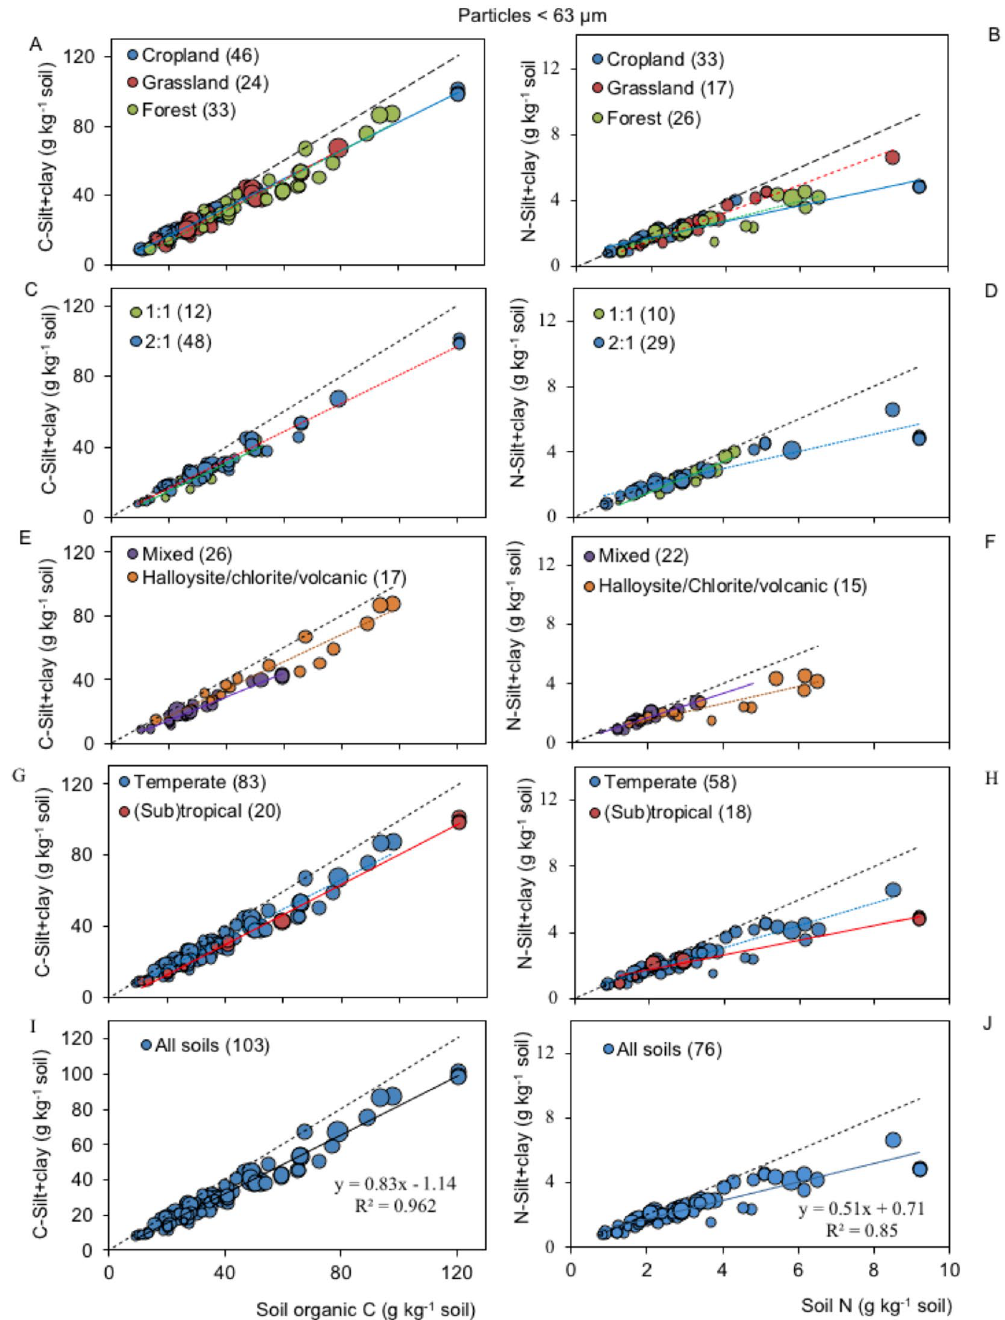
Figure 3. Relationship between soil organic carbon (SOC) content and C-silt + clay particles < 63 µm (n = 103) or total nitrogen and N-silt + clay < 63 µm (n = 76), grouped by ( A , B ) land use, ( C – F ) clay mineralogy, ( G , H ) climate and ( I , J ) all soils. The greater bubble size indicates high weight with lower standard errors. Long segmented line stands for 1:1. Short segmented or solid line stands for regression fitting to each categorical